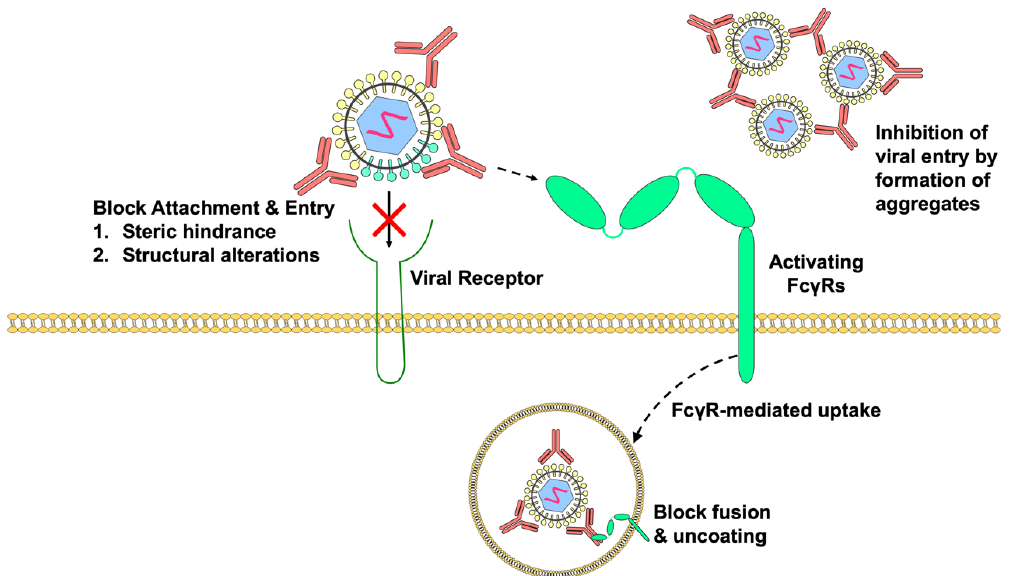
Figure 1. Mechanisms by which pre-existing antibodies neutralize LAVs. Antibodies can prevent attachment and entry of the virus, either via steric hindrance or by altering the conformation of the viral protein that binds the receptor. However, antibody binding to activating Fc γ Rs may still allow virus–antibody complex internalization via Fc γ R-mediated uptake, indicating that antibodies that prevent viral fusion and uncoating could be critical to ensure complete virus neutralization. High levels of antibodies can also lead to the formation of aggregates which inhibit viral entry.